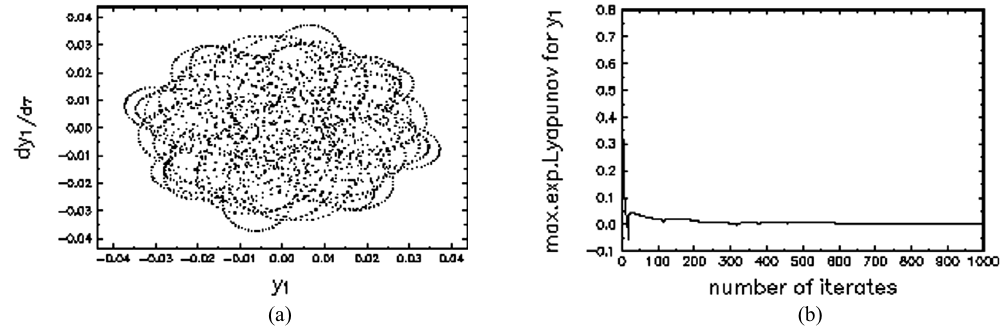
Fig. 8. Bifurcation diagrams of α for γ 4 = 0 (a) and γ 4 = 0.0005 (b) and for: a 1 = a 2 = 0.1; a 3 = 0.0001; γ 1 = 0.0001; γ 2 = γ 3 = 0; β 1 = 0.65; c = 1; u 2 = 1.5; q = 0.2.